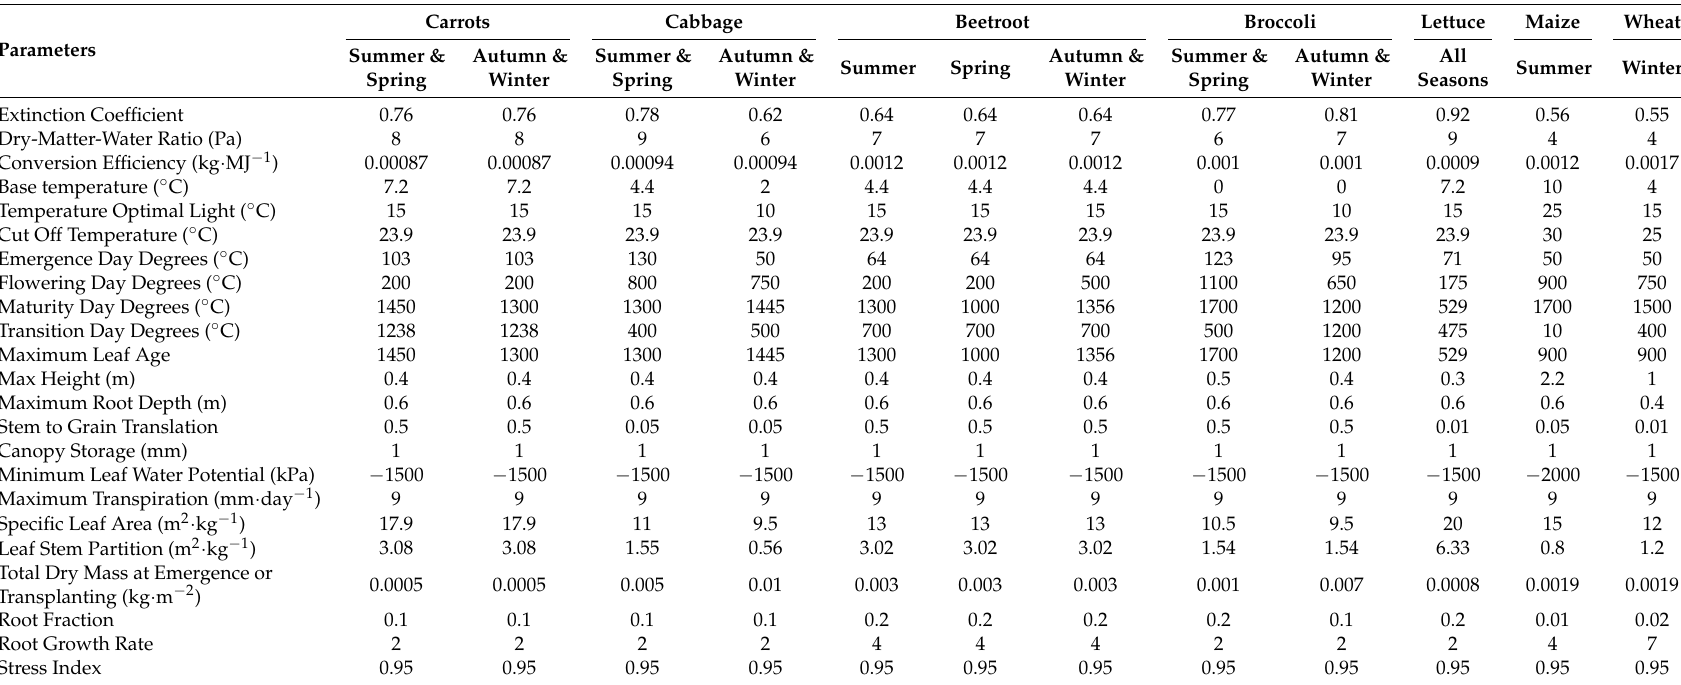
Table 1. Locally produced crop parameters used in the Soil Water Balance model to simulate the data required for WF calculations.